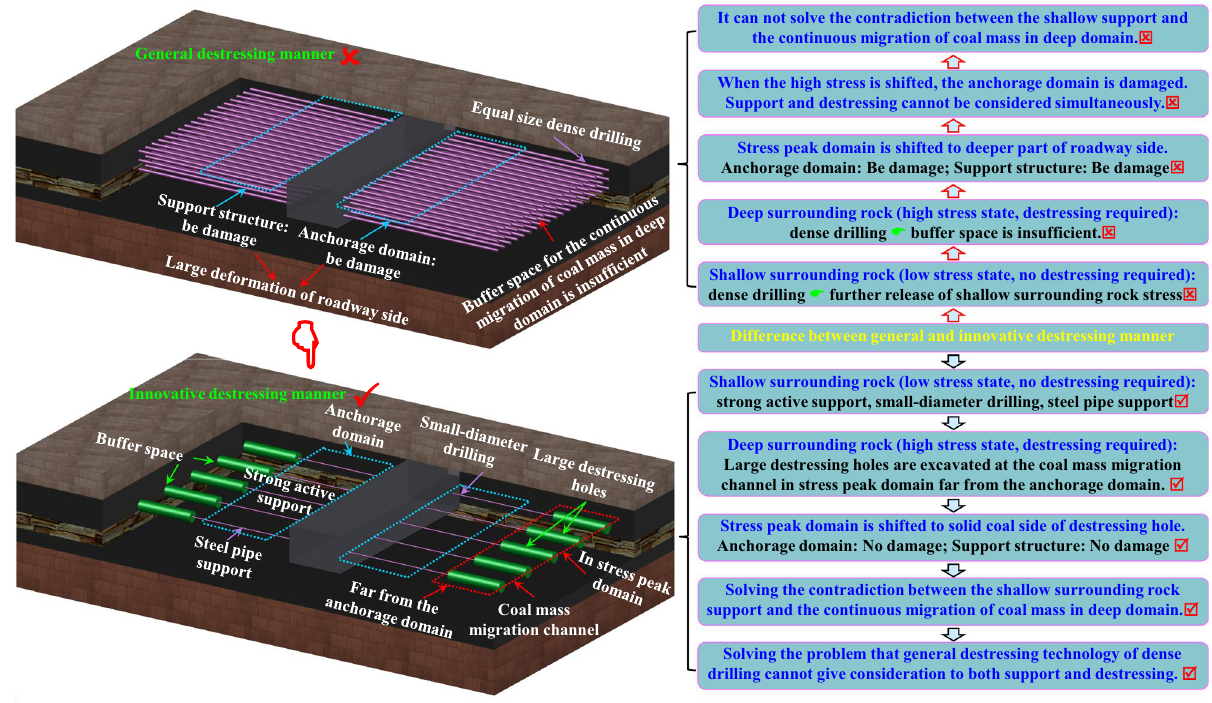
Figure 1. Difference between general and innovative destressing